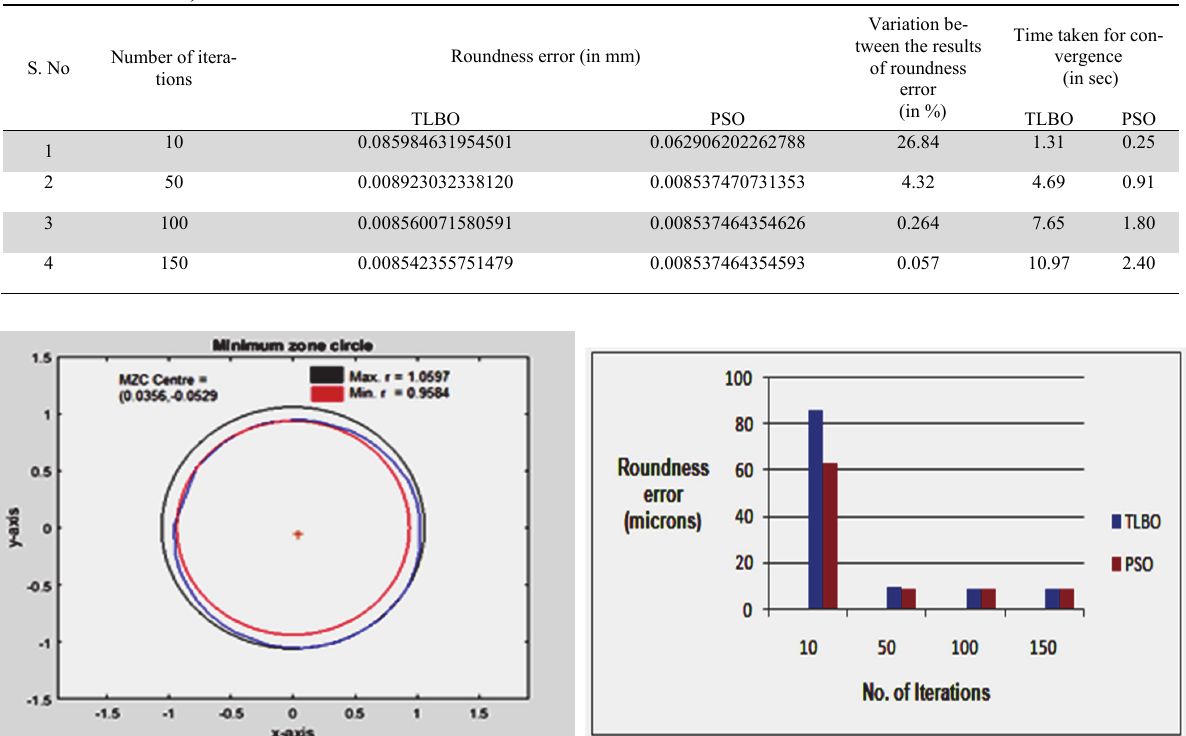
Fig. 5. Comparison of roundness error in terms of number of